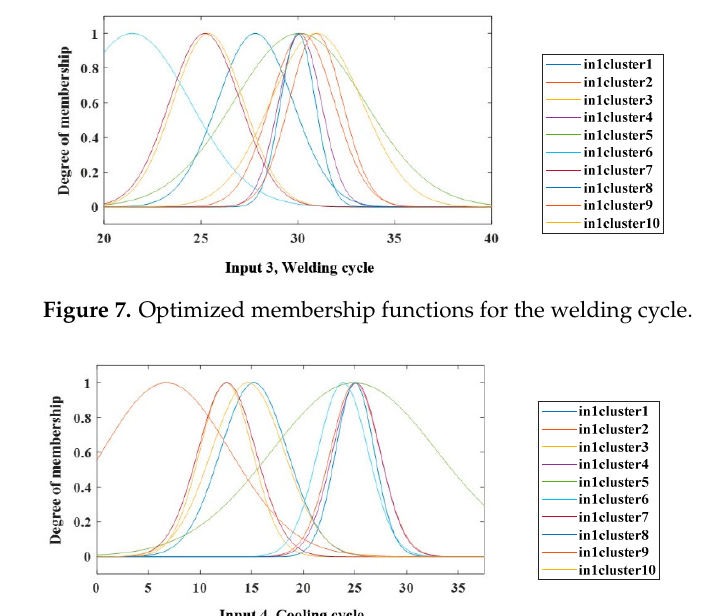
Figure 6. Optimized membership functions for the electrode force.